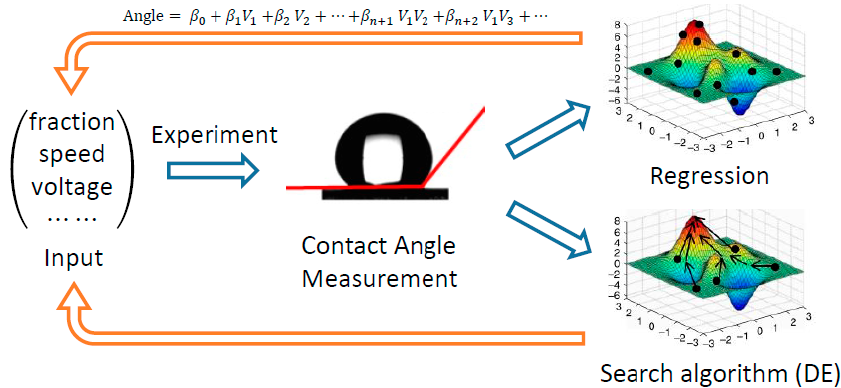
Figure 1. Schematic diagram of Feedback System Control (FSC) framework for optimization of the contact angle.